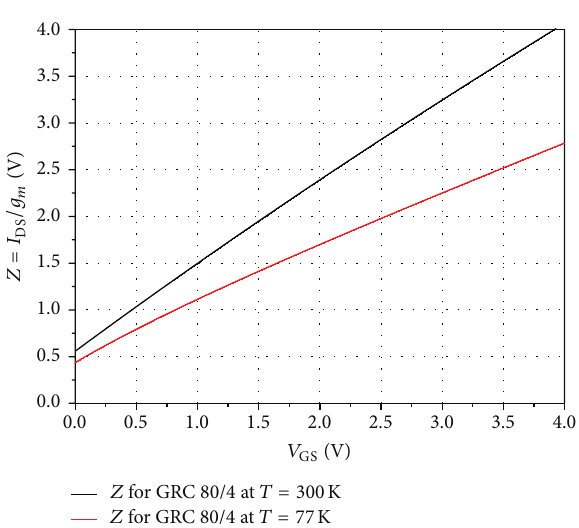
Figure 5: 𝑍 function versus 𝑉 80 𝜇 m/8 𝜇 m) at 300 K and 77 K measured in the saturation domain = 7V). 𝜃 1 is extracted from the reciprocal of the 𝑍 function ( 𝑉 DS intercept with vertical